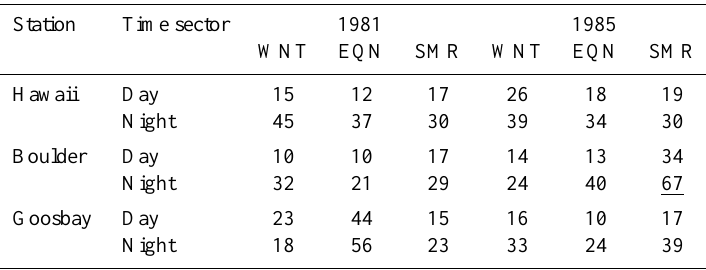
Table 4. Mean daytime (08:00–16:00LT) and night-time (20:00–04:00LT) variability of ionospheric slab thickness for solar maximum year 1981 and solar minimum year 1985 for magnetically quiet days.